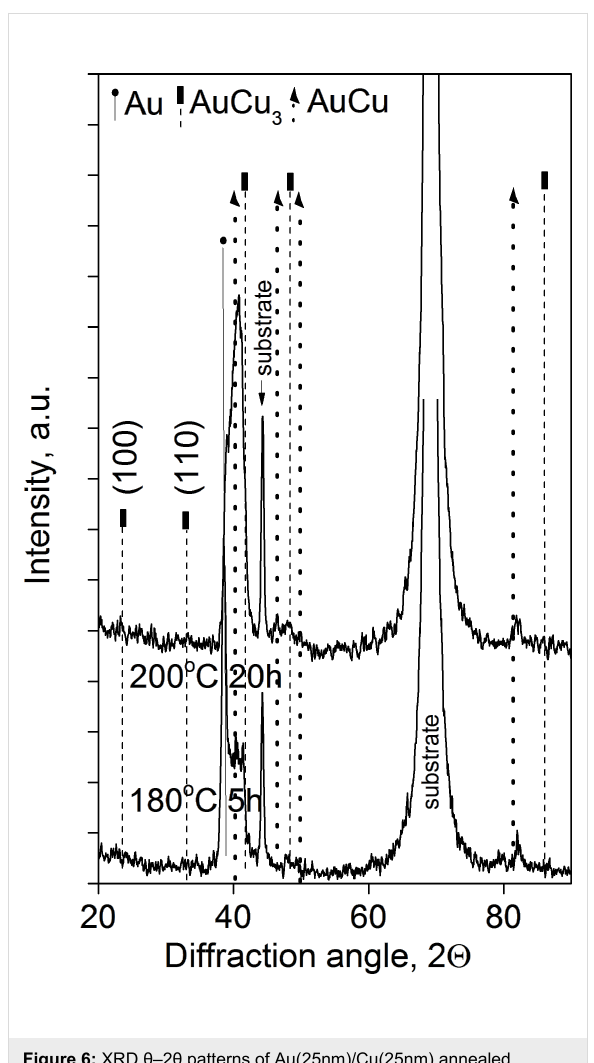
Figure 6: XRD θ –2 θ patterns of Au(25nm)/Cu(25nm) annealed